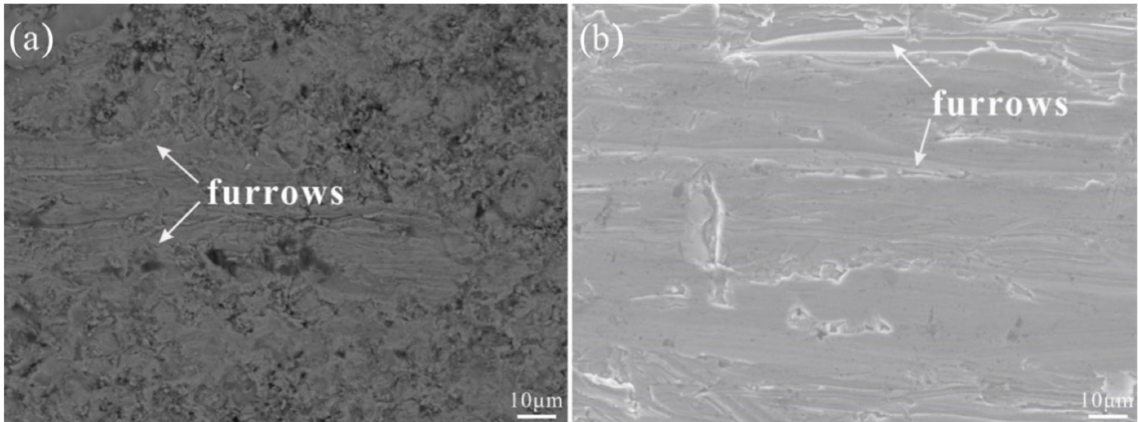
Figure 5. Surface morphologies of FeB-30 wt.% Al 0.25 FeNiCoCr coating and 316L stainless steel substrate after abrasive wear for 1200 revolutions: ( a ) coating, ( b ) 316L stainless steel.